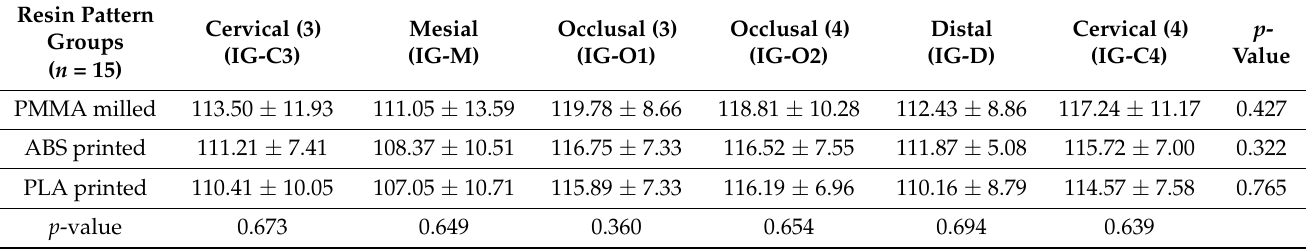
Table 5. Comparison of the internal gap on all six locations among the three different resin patterns in mesiodistal cross-section using Kruskal–Wallis